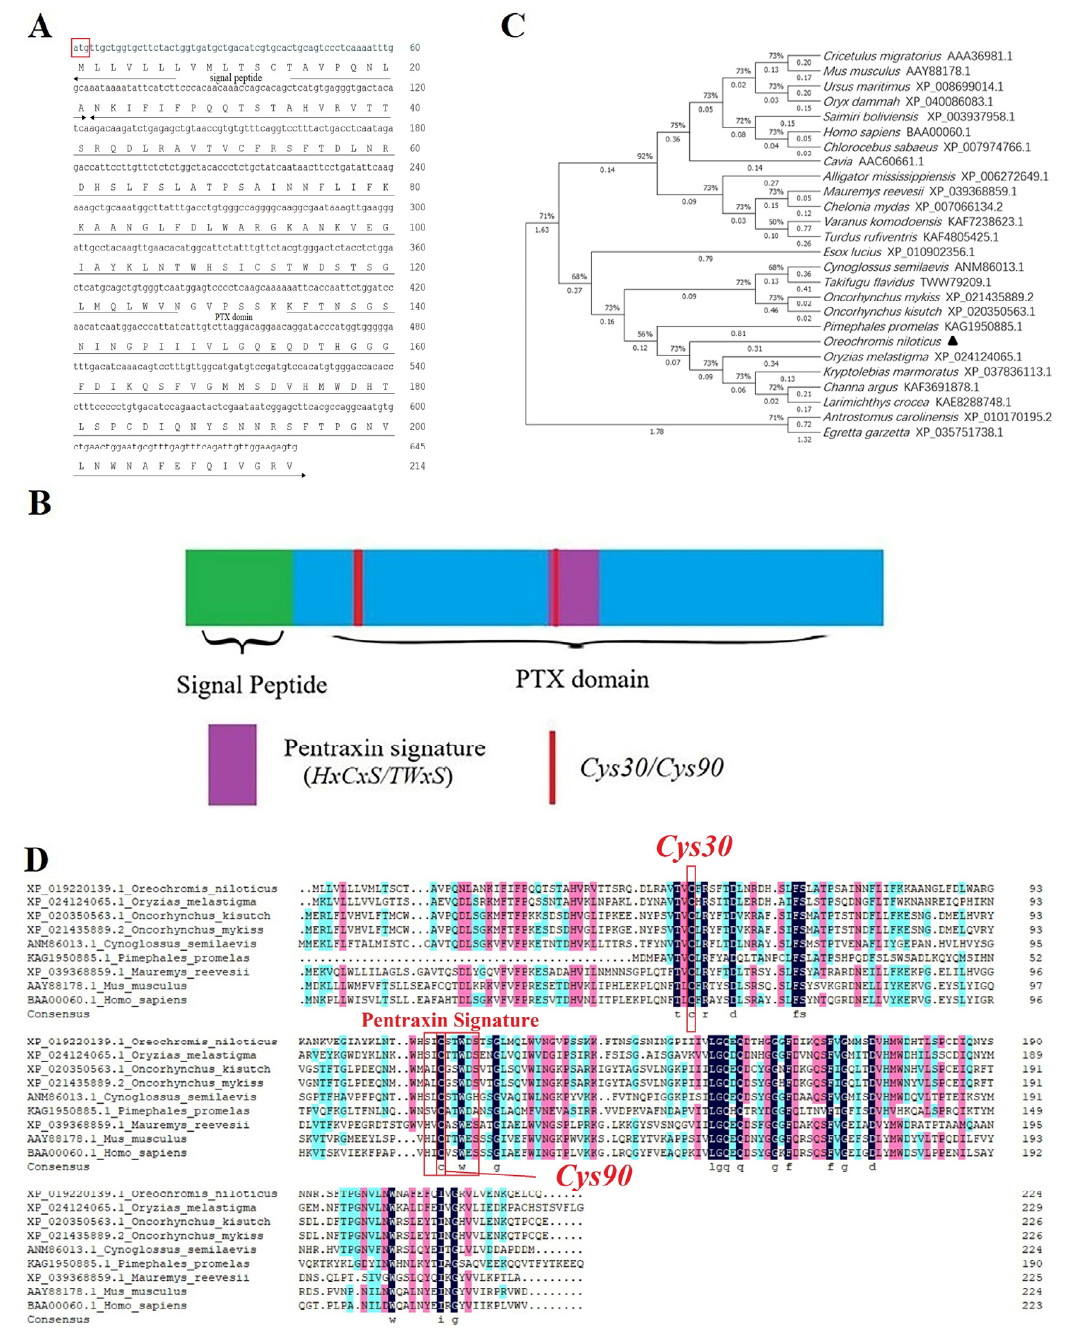
Figure 1. Sequence analysis of OnSAP. ( A , B ). Protein sequence analysis of OnSAP. PTX domain occupies the full length of the protein, and a conservative structure named Pentraxin signature is located in the middle of the protein. ( C ). Phylogenetic tree of SAP family members. Numbers at each branch indicated the percentage bootstrap values on 1000 replicates. ( D ). Multiple sequence alignment of the deduced amino acid sequences of SAP among different species. GenBank accession numbers of the used species for comparison are Homo sapiens (BAA00060.1), Mus musculus (AAY88178.1), Oryzias melastigma (XP_024124065.1), Oncorhynchus kisutch (XP_020350563.1), Cynoglossus semilaevis (ANM86013.1), Chelonia mydas (XP_007066134.2), respectively. The conservative motifs were highlighted in the red box, including important domains such as Cys36/Cys90 and the Pentraxin signature.